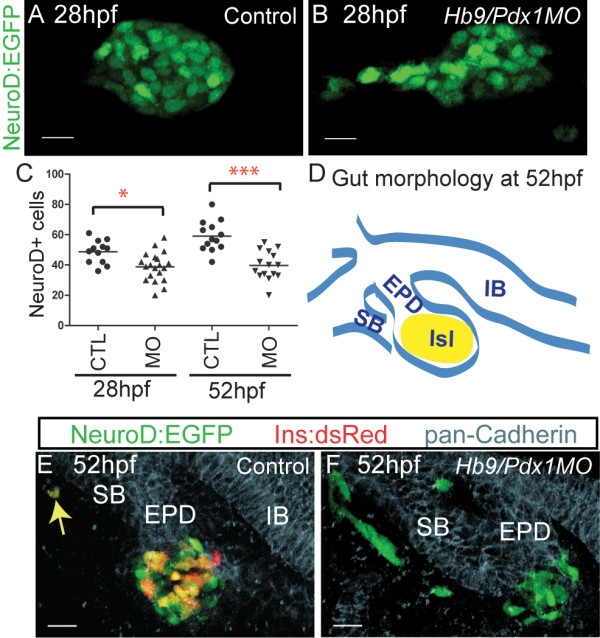
Disrupted precursor specification and differentiation in hb9/pdx1 double morphants. (A,B) Projections of confocal image stacks of native enhanced green fluorescent protein (EGFP) expression in control uninjected and in hb9/pdx1 morpholino injected TgBAC(NeuroD:EGFP)nl1 embryos at 28 h post fertilization (hpf). In morphants, the clustering of EGFP labeled cells is disrupted (B) and the number of EGFP expressing cells is reduced as compared to controls (C). By 52 hpf, NeuroD:EGFP cell numbers have increased in control embryos, but not changed in the morphants ((C), *P < 0.05, ***P < 0.001 as determined by one-way analysis of variance (ANOVA) with Bonferroni's post test). (D) Schematic depicting overall gut morphology in 52 hpf embryos. EPD, extrapancreatic duct; IB, intestinal bulb; ISL, islet; SB, swim bladder. (E,F) Confocal image projections of control uninjected (E) and hb9/pdx1 morpholino injected (F) TgBAC(NeuroD:EGFP)nl1;Tg(ins:dsRed)m1018 embryos at 52 hpf that were costained with antibodies against pan-cadherin (light blue) to outline epithelial structures. In control embryos, EGFP+ and EGFP+/DsRed+ cells are mainly found in the islet. A rare EGFP+/DsRed+ cell is seen in a distal location (E, arrow). In double morphants, few to no EGFP/DsRed-expressing cells can be detected and many EGFP+ cells are located at ectopic positions outside the developing gut epithelium (F). Scale bar = 15 μM in all panels. All embryos are shown from ventral view, anterior to the left.